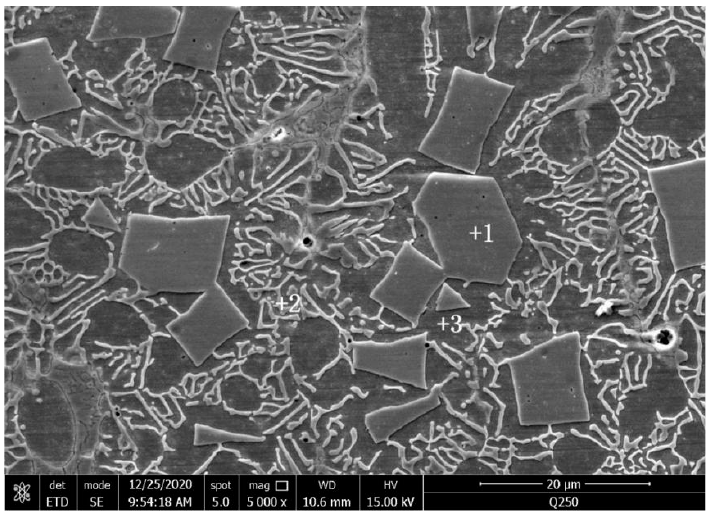
Figure 4. SEM image of the Fe–Cr–Mo–Ni–B coating. Table 2. Element contents of various regions.